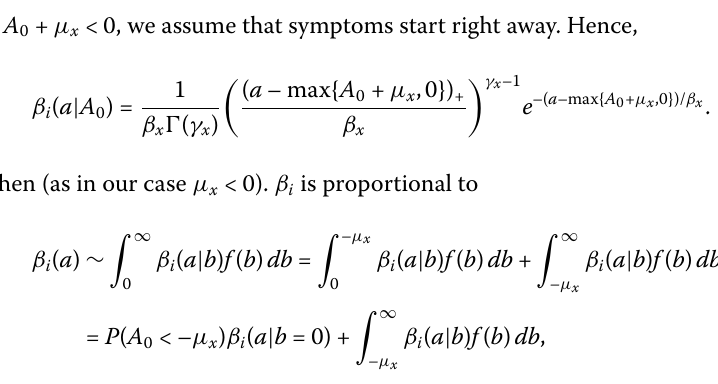
with the understanding that this formula is only valid for A 0 > – μ x . Here, ( x ) + = 0 for x < 0 and ( x ) + = x if x > 0. The parameters are given